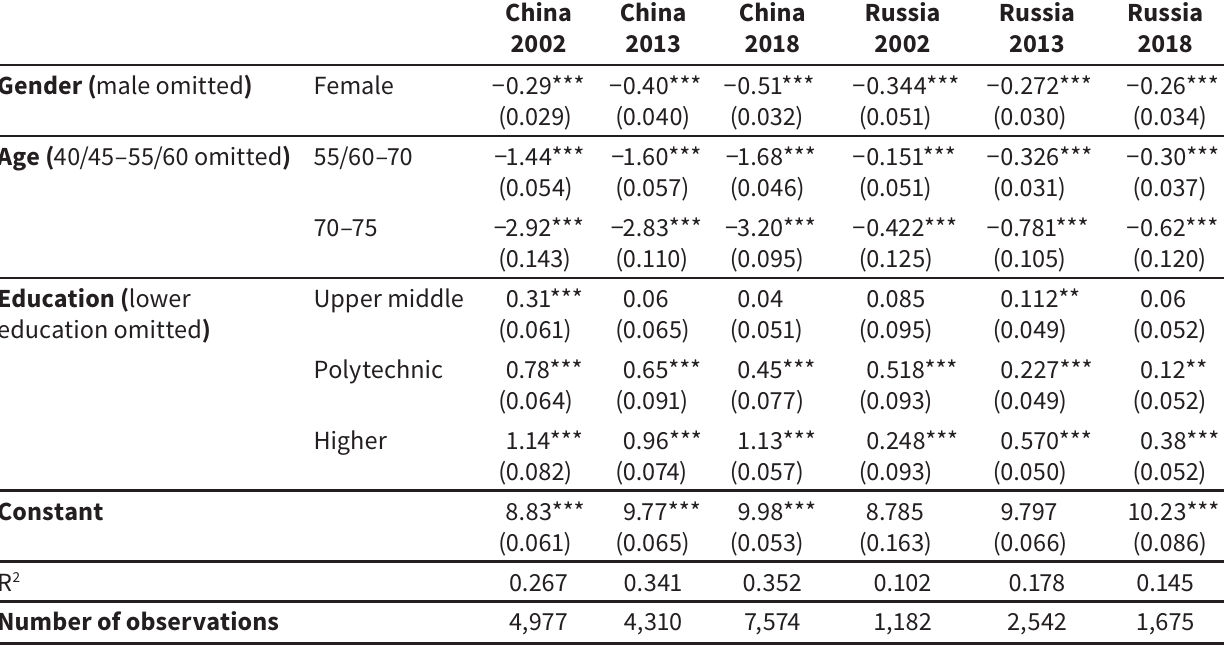
The relationship between age and earnings obtained from the earnings function for workers aged 40/45 and over in urban China and urban Russia in 2002, 2013, and 2018 Parsimonious